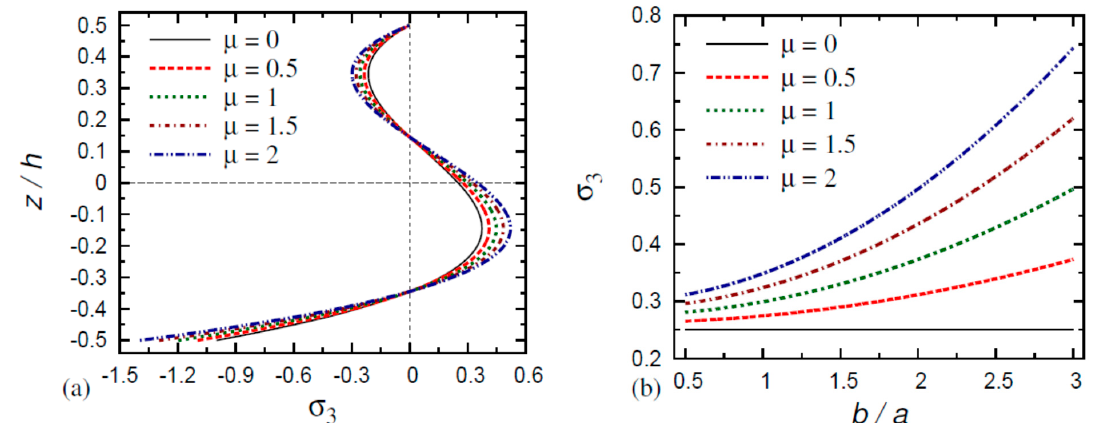
Figure 6. Variation in non-dimensional normal stress σ 3 of FG nanoplates ( a ) through the thickness ( a = b ) and ( b ) versus the aspect ratio b / a ( k = 1, a / h = 10 ). The variations in the normal stress σ (cid:2869) and transverse shear stress σ (cid:2872) through the thickness of